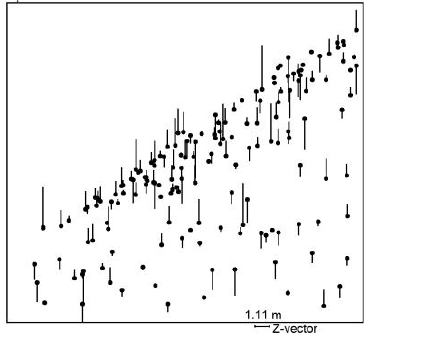
Figure 13. Vertical discrepancies at GCPs – 3D orientation of Pleiades with bias correction by shift; upper left = Black Sea